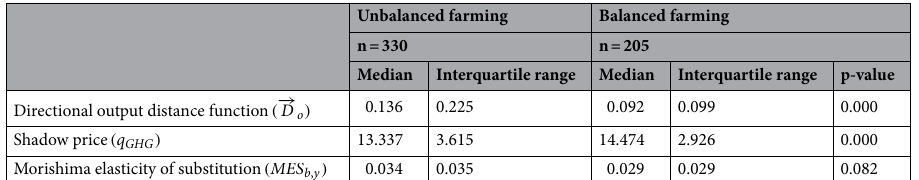
Table 3. Descriptive statistics, by production system, between livestock and aquaculture. Unbalanced farming indicates that livestock revenue accounts for 0–25% or 75–100% of the partial revenue of livestock and aquaculture, excluding rice. Balanced farming indicates that livestock or aquaculture accounts for